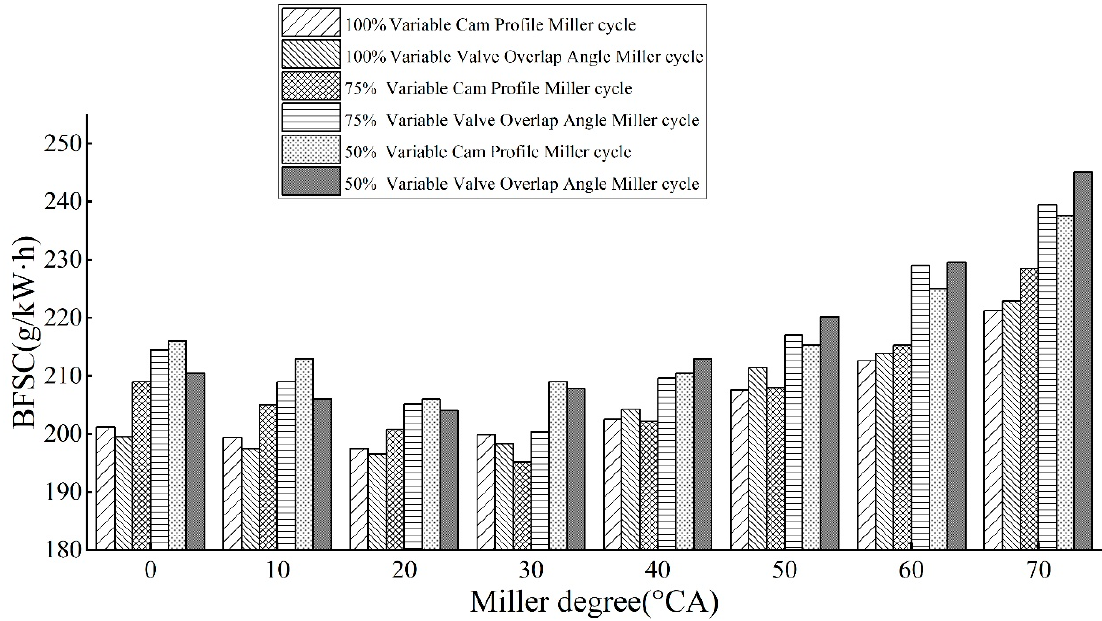
Figure 6. Fuel consumption analysis under three working conditions.